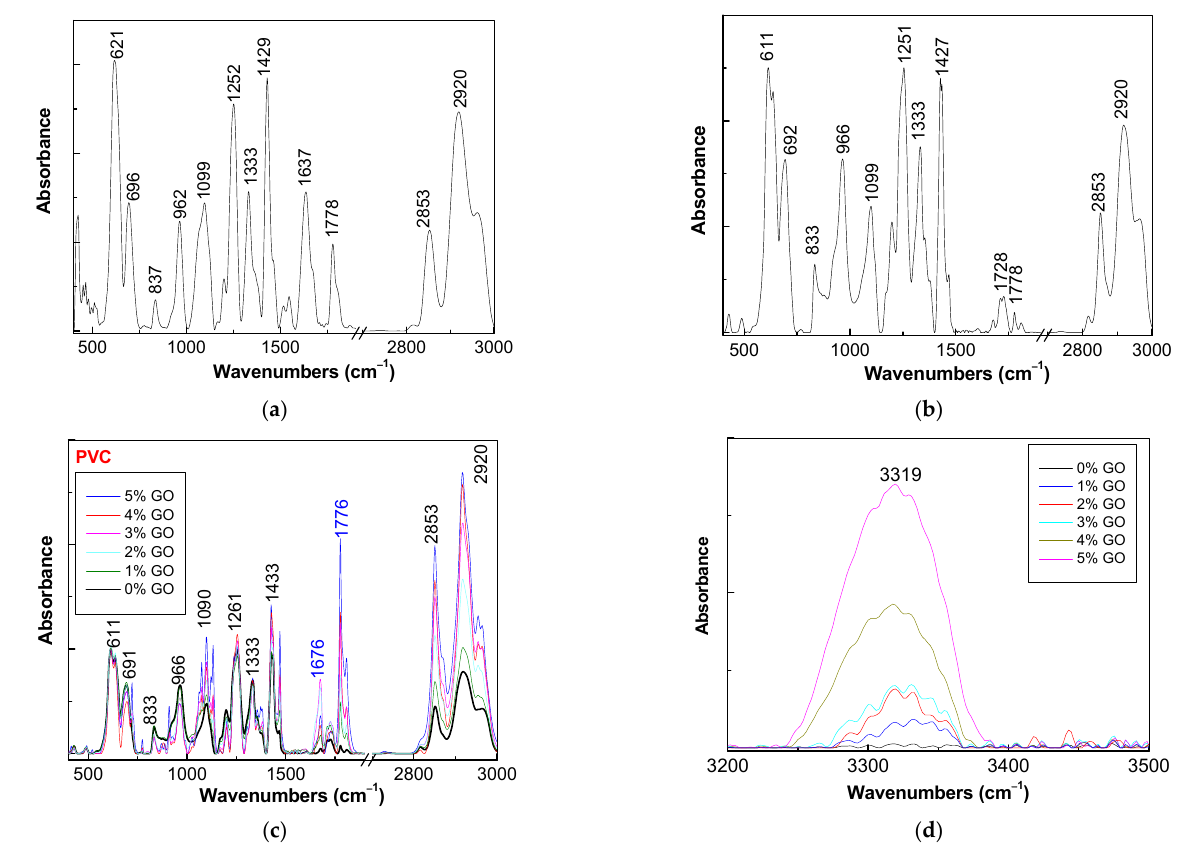
Figure 4. IR spectra of the PVC as grains ( a ) and spheres ( b ) as well as ( c ) their composites with PVC spheres (black curve), with a concentration of GO sheets equal to 1 wt.% (green curve), 2 wt.% (blue curve), 3 wt.% (magenta curve), 4 wt.% (red curve), and 5 wt.% (dark blue curve). Figure ( d ) shows the IR spectra of the GO sheets and their composites with PVC in the 3200–3500 cm − 1 spectral range. Table 2. Vibrational modes observed by FTIR spectroscopy in PVC